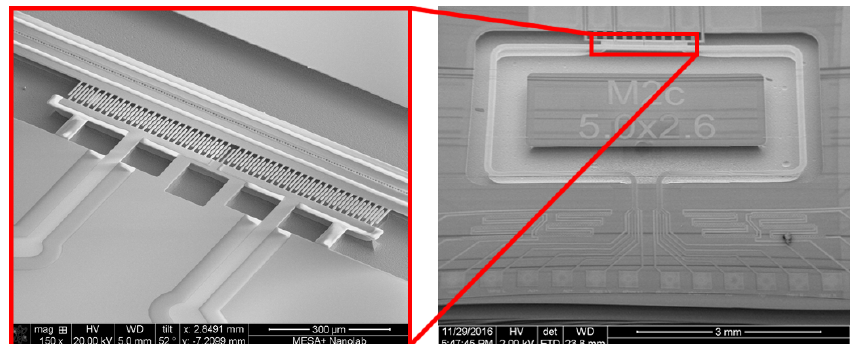
Figure 2. SEM image of a µ -Coriolis mass flow sensor with capacitive readout. The capacitive readout consists of two comb capacitor structures used for measuring displacement of the micro-channel.